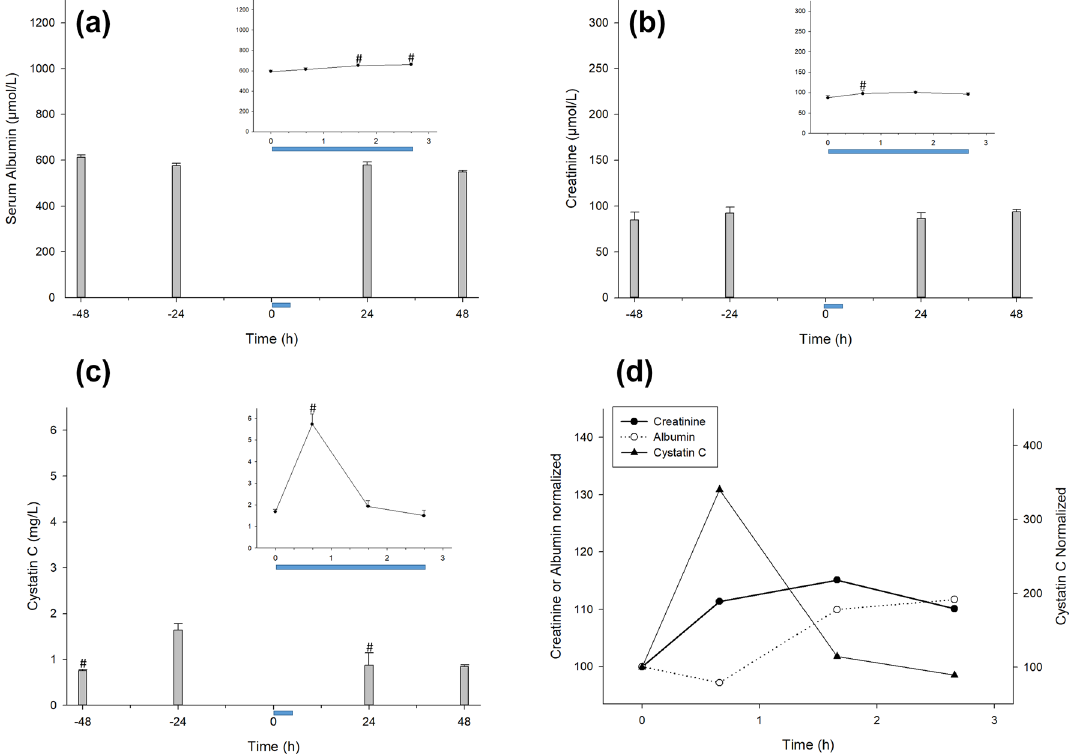
Figure 5. Both serum creatinine and cystatin C increased after the CCombat protocol, followed by serum albumin. ( a ) Serum albumin (HSA) #Pre vs. + 60 min: p = .008; effect size = 0.9; statistical power = 0.93; #Pre vs . + 120 min: p = .001; effect size = 1.2; statistical power = 0.99; ( b ) serum creatinine #Pre vs. Post: p = .047; effect size = 0.7; statistical power = 0.80; ( c ) cystatin C #Pre vs . − 48 h: p < .001; effect size = 2.4; statistical power = 1.00; #Pre vs . Post: p < .001; effect size = 2.4; statistical power = 1.00; #Pre vs . + 24 h: p = .007; effect size = 0.8; statistical power = 0.89; #Pre vs . + 48 h: p < .001; effect size = 2.2; statistical power = 1.00 and ( d ) normalized HSA, creatinine and CysC. The blue bar represents the CCombat protocol in scale in both graphs. AVG ±